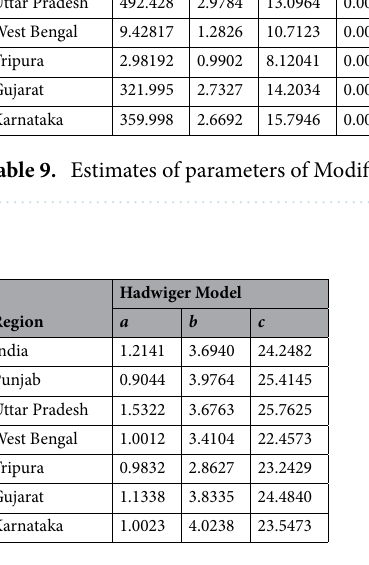
Table 10. Estimates of parameters of Hadwiger Model for India and 6 selected states.